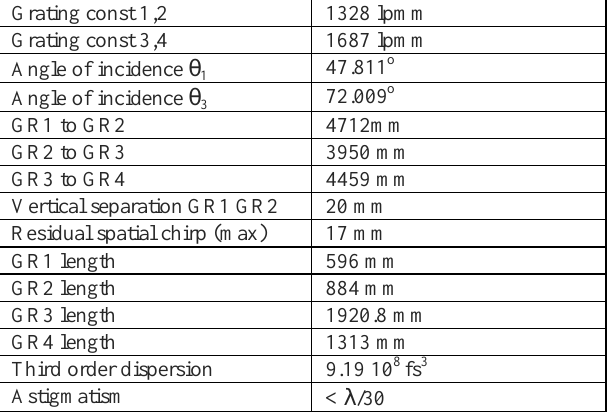
Table 1: Resulting parameters of the compressor.